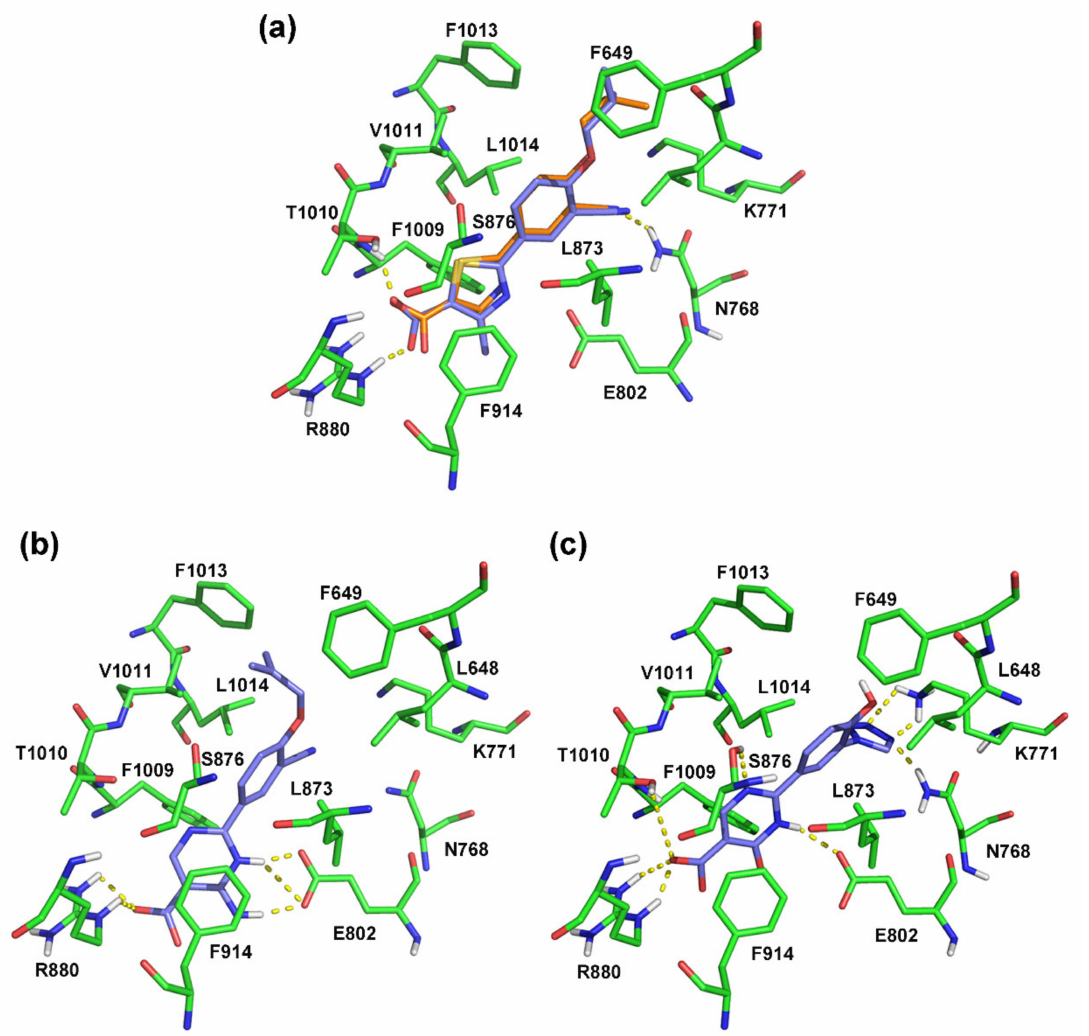
Figure 6. The docking results of febuxostat ( a ), compound 44 ( b ), and compound 26 ( c ) in the binding site of protein (PDB ID: 1N5X). The crystal ligand, redocked ligand, important residues, and hydrogen bond were shown in orange sticks, blue sticks, green sticks, and yellow dashes,